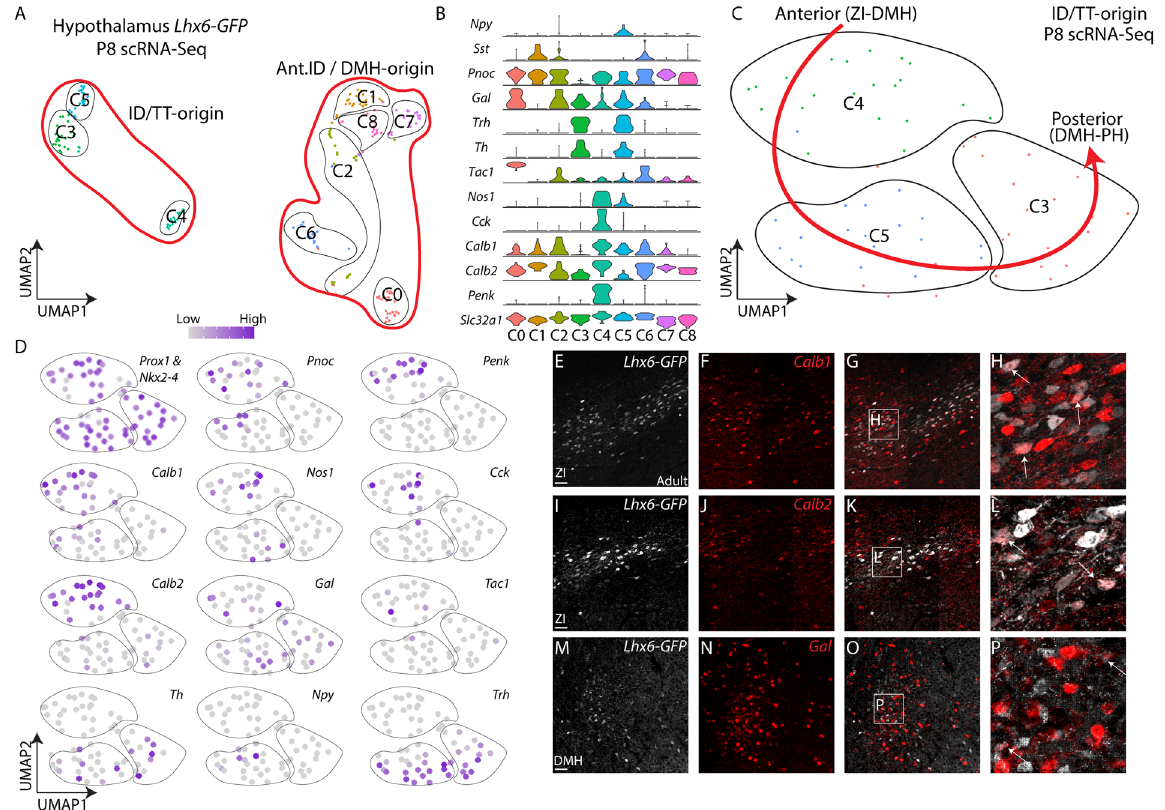
Fig. 3 Diverse subtypes of mature hypothalamic Lhx6-expressing neurons. A Uniform Manifold Approximation and Projection (UMAP) plot showing hypothalamic Lhx6-expressing GABAergic neurons at P8 scRNA-Seq. B Violin plots showing key markers in individual clusters in ( A ). C UMAP plot showing Lhx6-expressing neurons originated from ID and TT. D UMAP plots showing the distribution of diverse neuropeptides and neurotransmitters across ID and TT derived Lhx6-expressing neurons. E – P Fluorescent in situ hybridization showing Lhx6-GFP (gray) with Calb1 (red, E – H ), Calb2 (red, I – L ), and Gal (red, M – P ). Scale bar = 50 μ